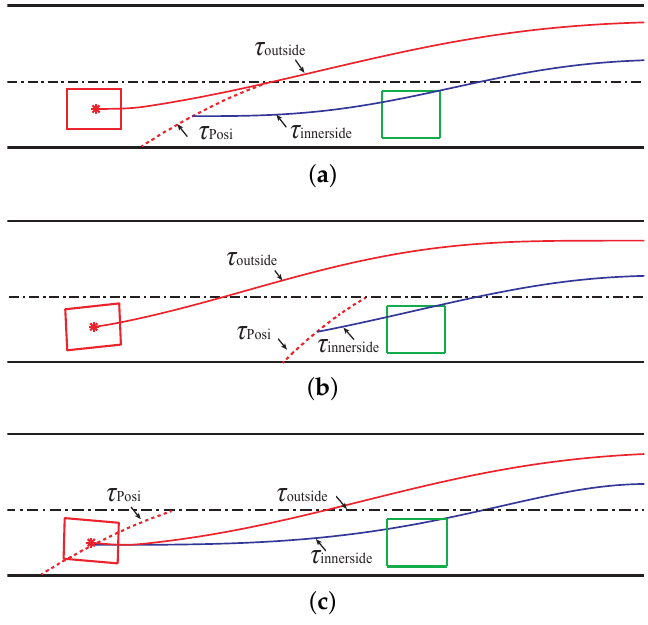
Figure 20. The boundary trajectories for avoiding collision with a slow front vehicle. ( a ) The boundary trajectories of lane-change maneuver, ϕ ( t 0 ) = 0. ( b ) The boundary trajectories of lane- change maneuver, ϕ ( t 0 ) > 0. ( c ) The boundary trajectories of lane-change maneuver, ϕ ( t 0 ) < 0. The red rectangle represents the host vehicle, the green rectangle represents the vehicle L 0 . The dashed red line τ posi denotes the safe position obtained according to the safe distance derived in Section 2.3, the solid red line τ outside denotes the boundary trajectory to arrive at the outermost lateral safe position, the solid blue line τ innerside denotes the boundary trajectory to arrive at the innermost lateral safe position. The line τ innerside starts from the corresponding point on line τ posi . From Figure 20, we can see that the driving envelope considers not only the safe distance to obstacles, but also the input of the